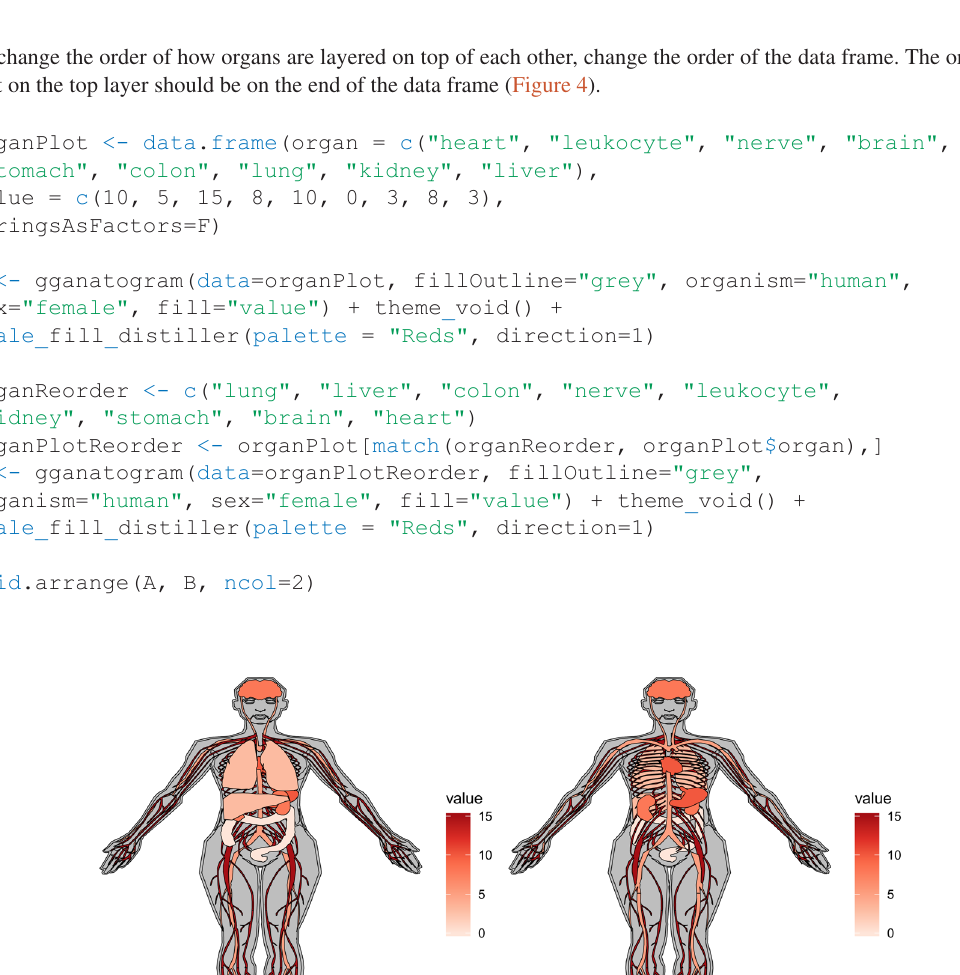
Organs can also be separated by faceting, as per standard ggplot2 using facet_wrap (Figure 5). This can help to display organs that are nested on top of each other. On the left, lungs and liver hides other plotted organs. This is corrected to the right in order to show the organs of